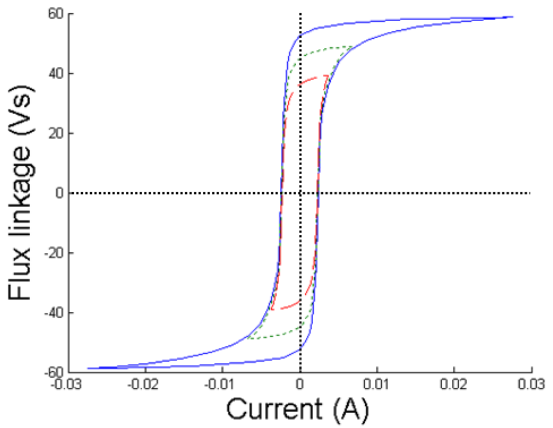
Figure 5. Hysteresis loops for the 120%, 100%, and 80% of the rated voltage.